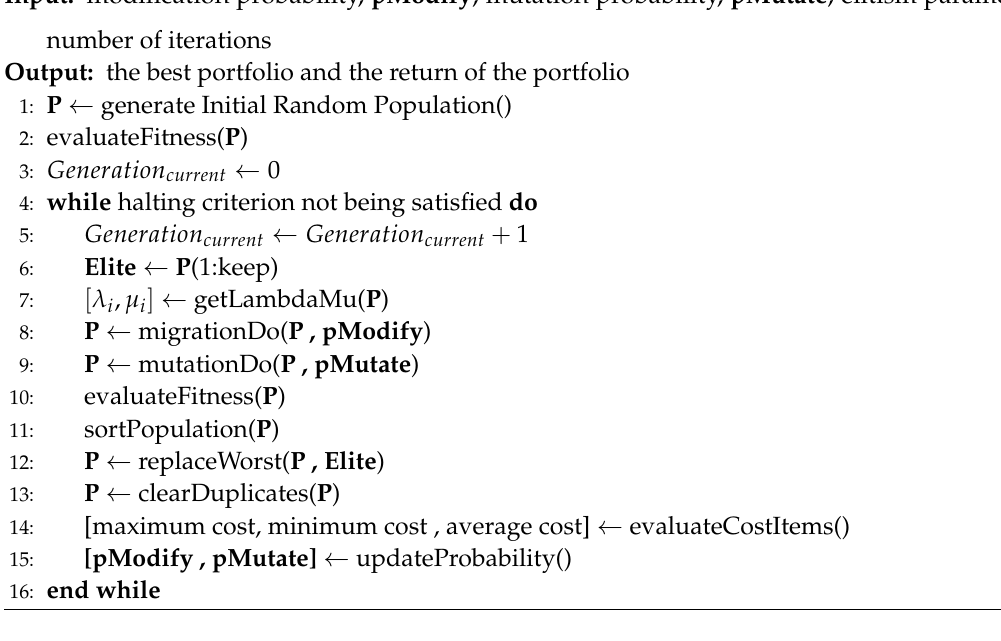
Algorithm 2 the main algorithm of sortPopulation (Population P